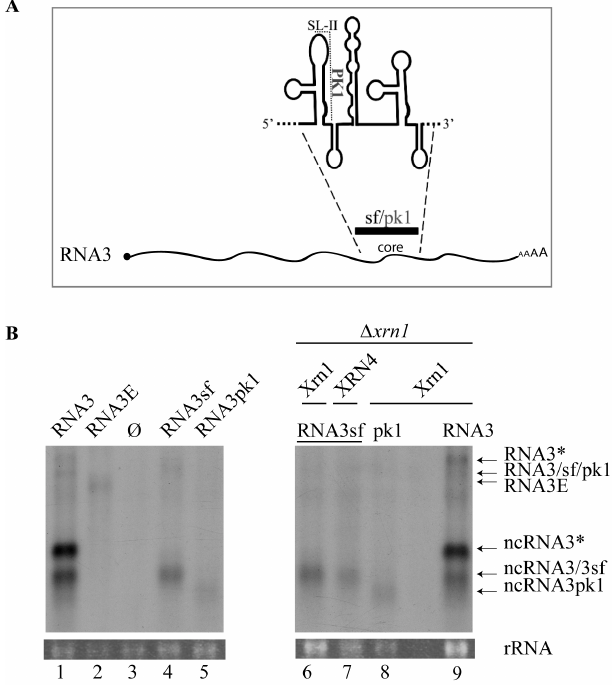
Figure 2. Accumulation of noncoding RNA3sf from chimeric RNA3sf inhibits Xrn1 and AtXRN4 exoribonucleases in Saccharomyces cerevisiae . ( A ) The ‘core’ sequence was replaced by a wt (sf) or mutated (pk1) flavivirus sequence to produce RNA3sf and RNA3pk1, respectively. PK1 pseudoknot involving stem-loop II (SL-II) is shown; ( B ) northern blot analyses of RNA3 and ncRNA species produced in yeasts. Plasmids allowing the expression of RNA species indicated that RNA3, RNA3E, RNA3sf, RNA3pk1, or empty vector (Ø) were introduced in wt yeasts (lanes 1–5) or